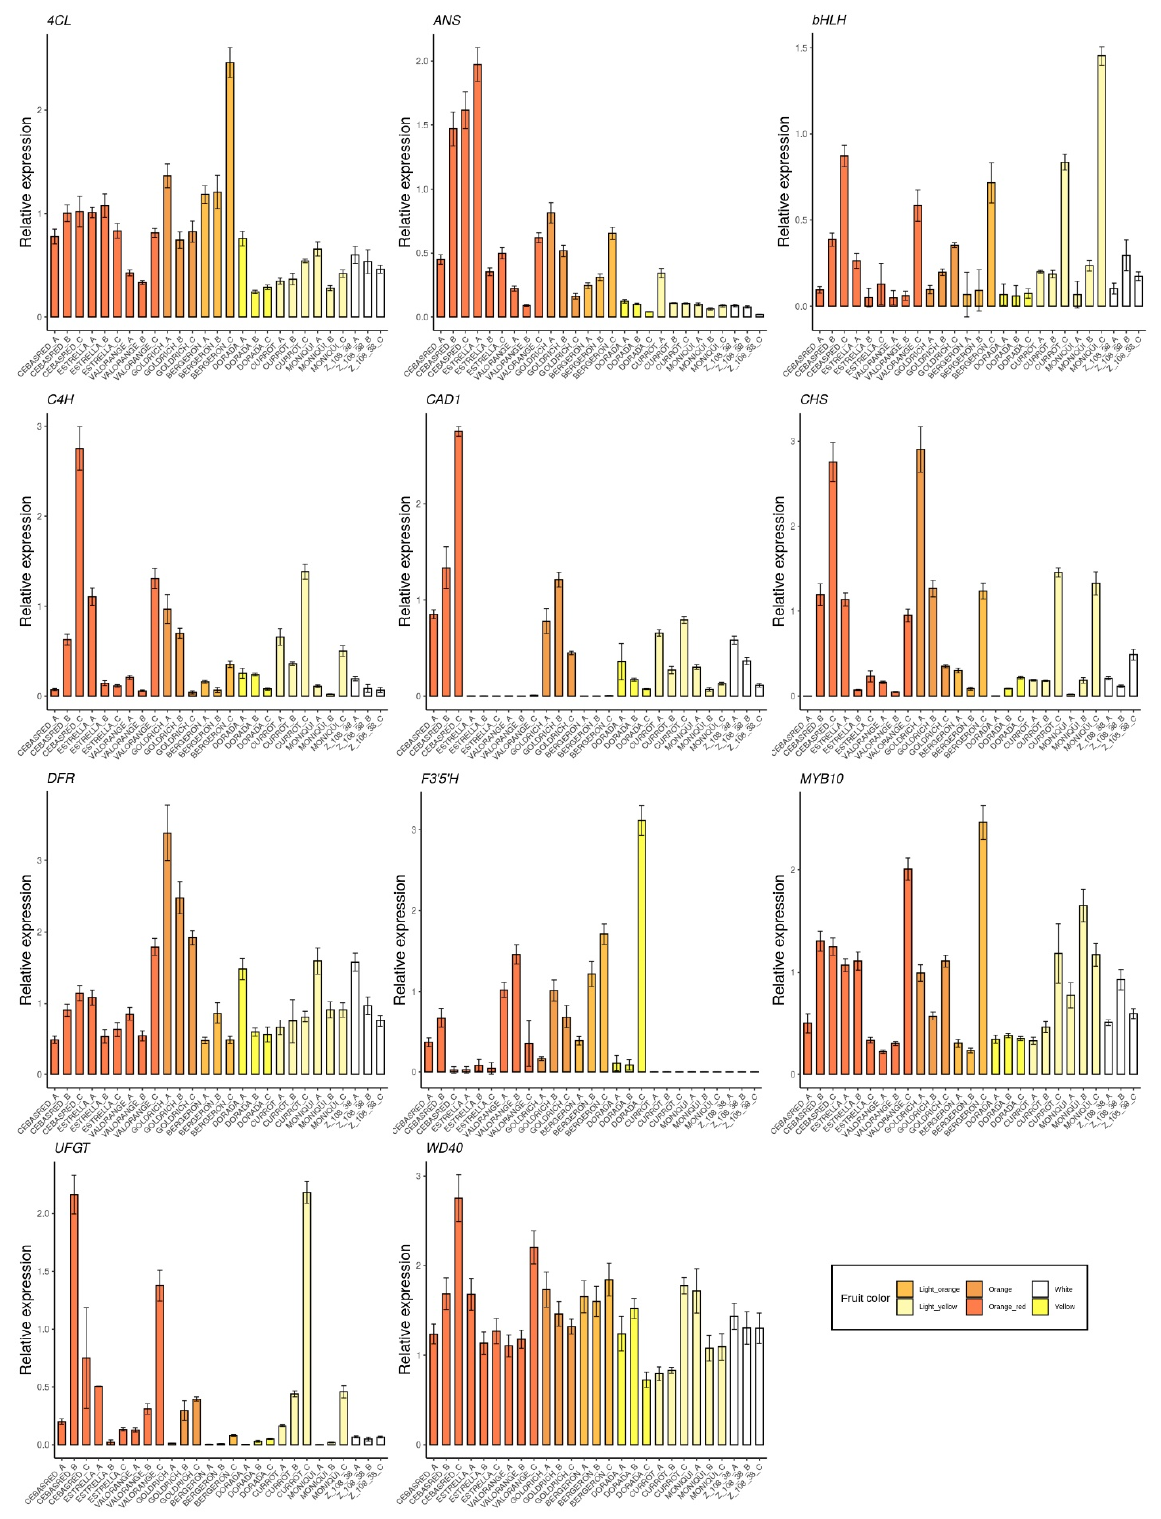
Figure 5. Expression dynamics barplots of the genes involved in anthocyanin biosynthesis (4CL, ANS, bHLH, C4H, CAD1, CHS, DFR, F3 ′ 5 ′ H, MYB10, UFGT and WD40 ) in the nine cultivars ‘Bergeron’, ‘Cebasred’, ‘Currot’, ‘Dorada’, ‘Estrella’, ‘Goldrich’, ‘Moniquí’, ‘Valorange’ and ‘Z 108-38 ′ at three different ripening stages based on their skin ground color and firmness: green fruit (_A), during color change (_B) and at physiological ripening (_C).